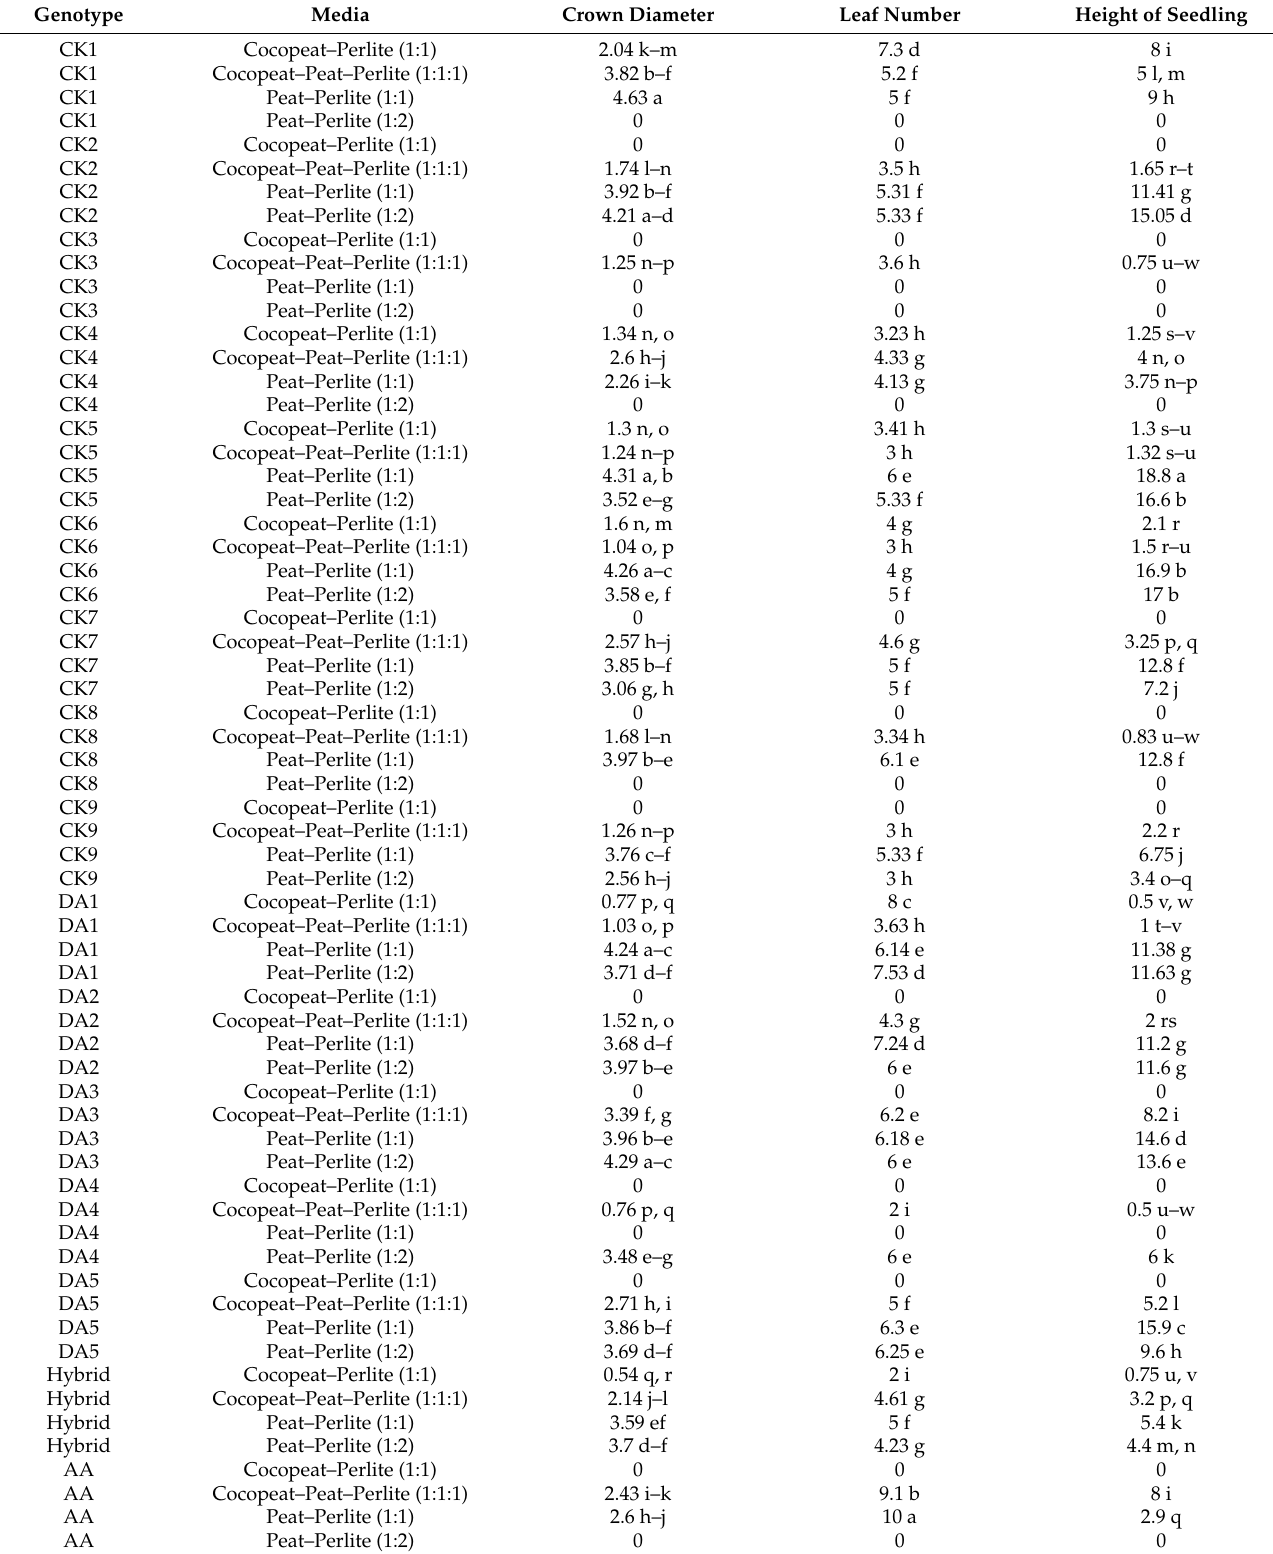
Table 4. Genotype and media interaction effects on crown diameter, leaf number and height of kiwifruit seedlings. Genotype Media Crown Diameter Leaf Number Height of Seedling